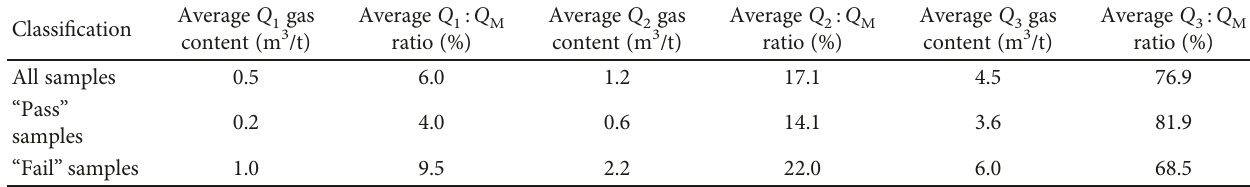
Table 5: The individual content of each gas component and the total gas content of each